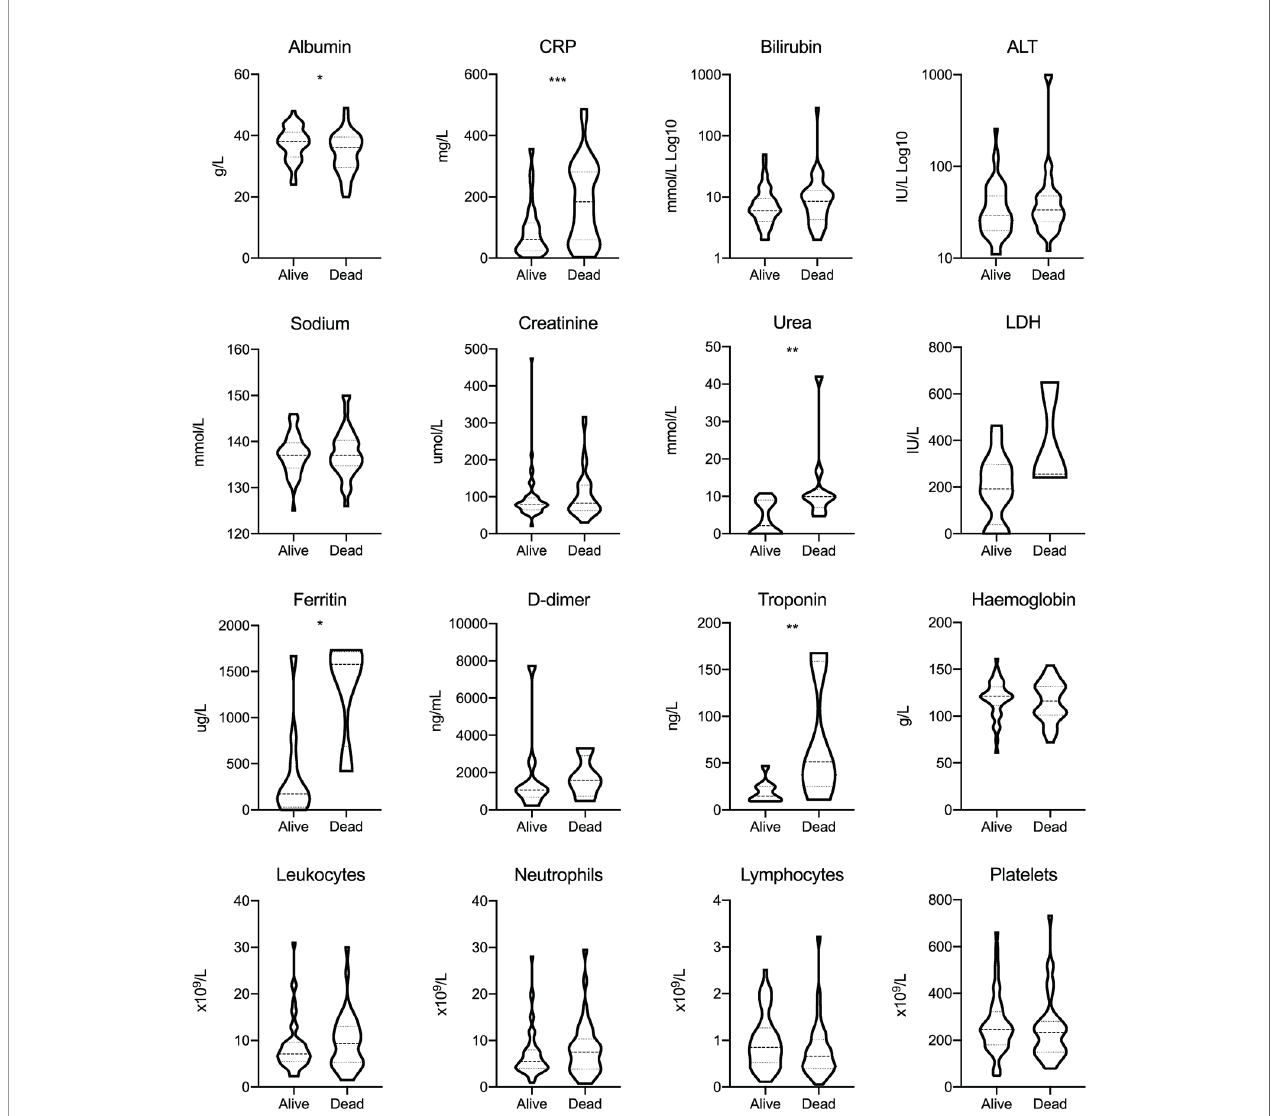
FIGURE 1 | Blood investigations for patients with cancer at presentation with SARS-CoV-2 infection. Dashed lines represent the median and dotted lines represent the IQR. * p < 0.05; ** p < 0.01; *** p < 0.001; CRP, C-reactive protein; ALT, alanine transaminase; LDH, lactate